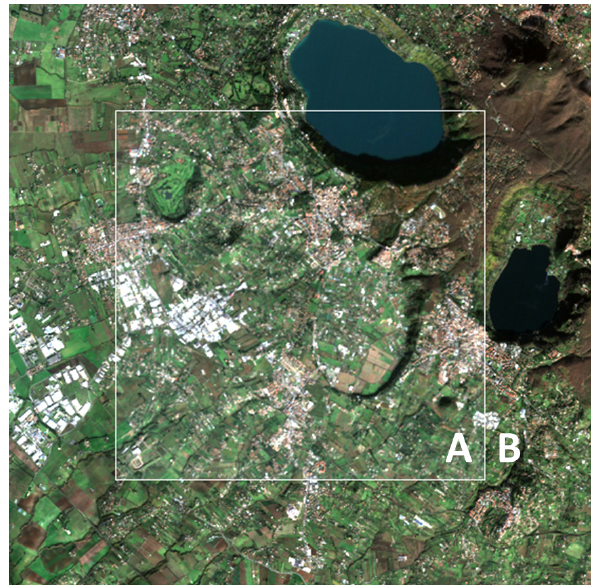
Figure 2. True color combination for a cloud-free subset from the Sentinel-2 Stack analysed in this paper. The area denoted with an A is assumed to be covered by thick clouds and therefore invisible. The dictionaries used for the sparse reconstruction are built by collecting random pixels from the area in a buffer around the cloud, denoted with a B.